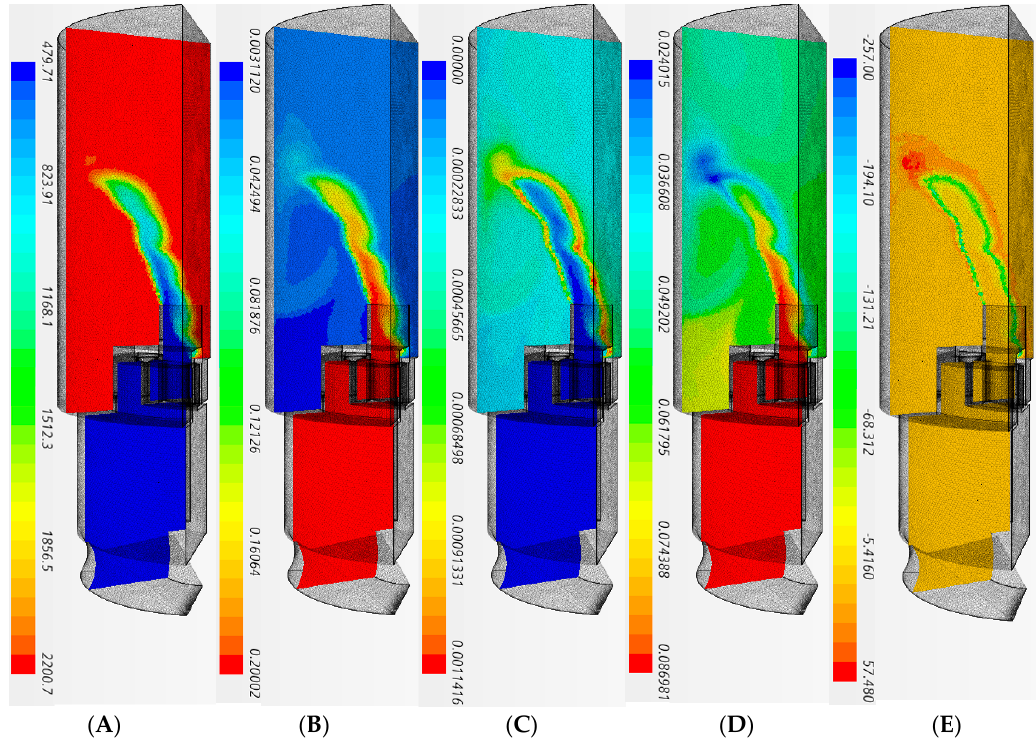
Figure 9. ( A ) Temperature (K); ( B ) ammonia concentration (mol%); ( C ) NO concentration (mol%); ( D ) hydrogen concentration (mol%); ( E ) hydrogen rate of production (kg/m 3 ·s). Operating conditions: 900 kPa, 500 K inlet temperature, adiabatic quartz tube.